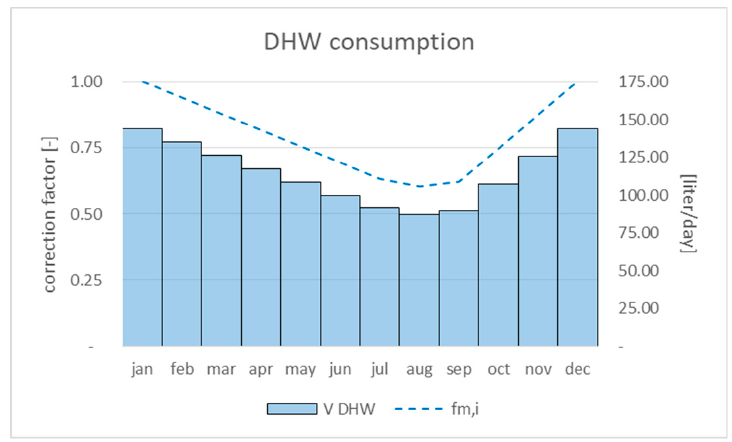
◦ C for analyzed consumer residential